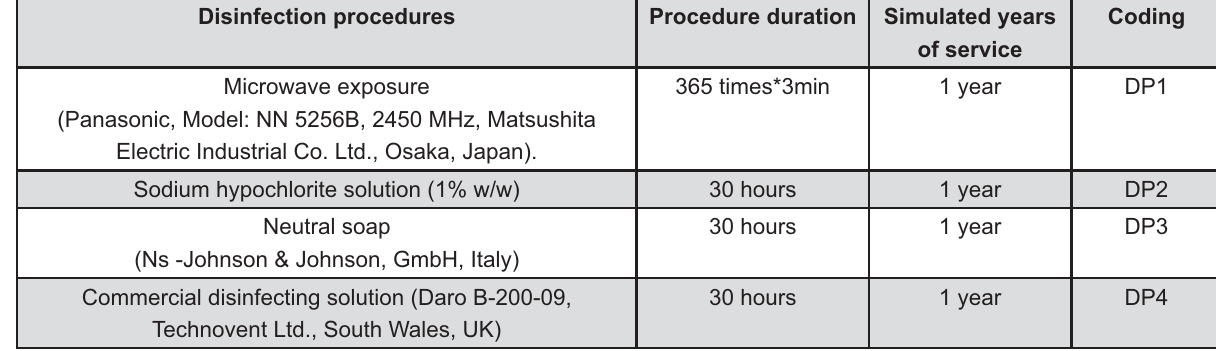
Figure 2- Disinfection procedures applied Table 1- (cid:5)(cid:6)(cid:7)(cid:8)(cid:9)(cid:7)(cid:10)(cid:11)(cid:5)(cid:10)(cid:12)(cid:10)(cid:13)(cid:11)(cid:14)(cid:15)(cid:14)(cid:5)(cid:8)(cid:16)(cid:5)(cid:17)(cid:10)(cid:18)(cid:15)(cid:10)(cid:12)(cid:19)(cid:20)(cid:5)(cid:18)(cid:20)(cid:14)(cid:21)(cid:13)(cid:22)(cid:14)(cid:5)(cid:16)(cid:8)(cid:18)(cid:5)(cid:2)(cid:3)(cid:5)(cid:10)(cid:12)(cid:23)(cid:5)(cid:2)(cid:4)(cid:5)(cid:24)(cid:20)(cid:10)(cid:14)(cid:21)(cid:18)(cid:20)(cid:24)(cid:20)(cid:12)(cid:22)(cid:14) Source Sum of Squares